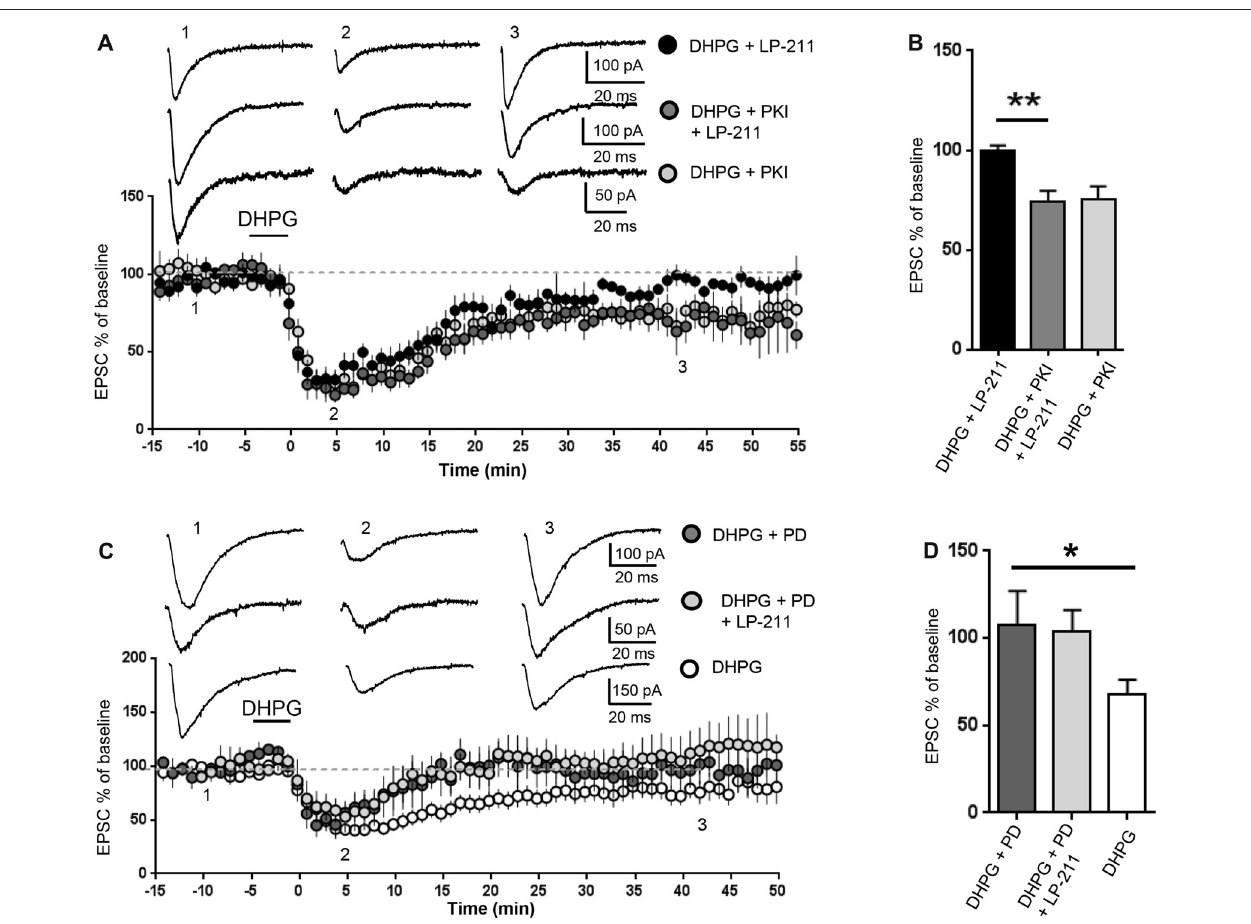
FIGURE 4 | 5-HT 7 receptor-mediated reversal of mGluR-LTD required protein kinase A (PKA) and was occluded by inhibition of extracellular signal regulated kinase (ERK). mGluR-LTD was induced by bath application of DHPG (100 µ M, 5 min) in WT slices in control conditions and in the presence of peptide fragment 6–22 (PKI, added to intracellular solution), an inhibitor of PKA. (A) Application of LP-211 (10 nM, 5 min) reversed mGluR-LTD in control conditions (black dots, n = 7) but had no effect in the presence of PKI (dark gray dots, n = 5). (B) In the presence of PKI, the effect of LP-211 was significantly reduced ( ∗∗ P = 0.0013, by unpaired t -test), indicating that PKA activation was necessary for 5-HT 7 R-mediated reversal of mGluR-LTD. (C) mGluR-LTD was induced by bath application of DHPG (100 µ M, 5 min) in WT slices in control conditions (white dots, n = 11) and in the presence of the mitogen-activated protein kinase (MAPK)/ERK blocker PD-98059 (PD, 40 µ M, added to intracellular solution). Intracellular PD-98059 completely reversed mGluR-LTD (dark gray dots, n = 5) and occluded the effect of LP-211 (10 nM, 5 min; gray dots, n = 5). (D) mGluR-LTD was significantly reversed by PD-98059 ( ∗ P = 0.03) and was not further modified by LP-211 ( P = 0.52).